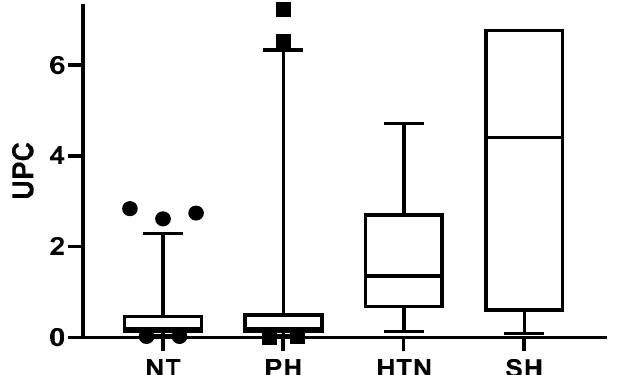
Figure 4. UPC in relation to SBP. Kruskal-Wallis ( p < 0.0011) post hoc Dunn’s test minimum and maximum values are presented, in addition to quartiles 1 and 3. Abbreviations: NT, normotension; PH, prehypertension; HTN, hypertension; HS, severe hypertension.